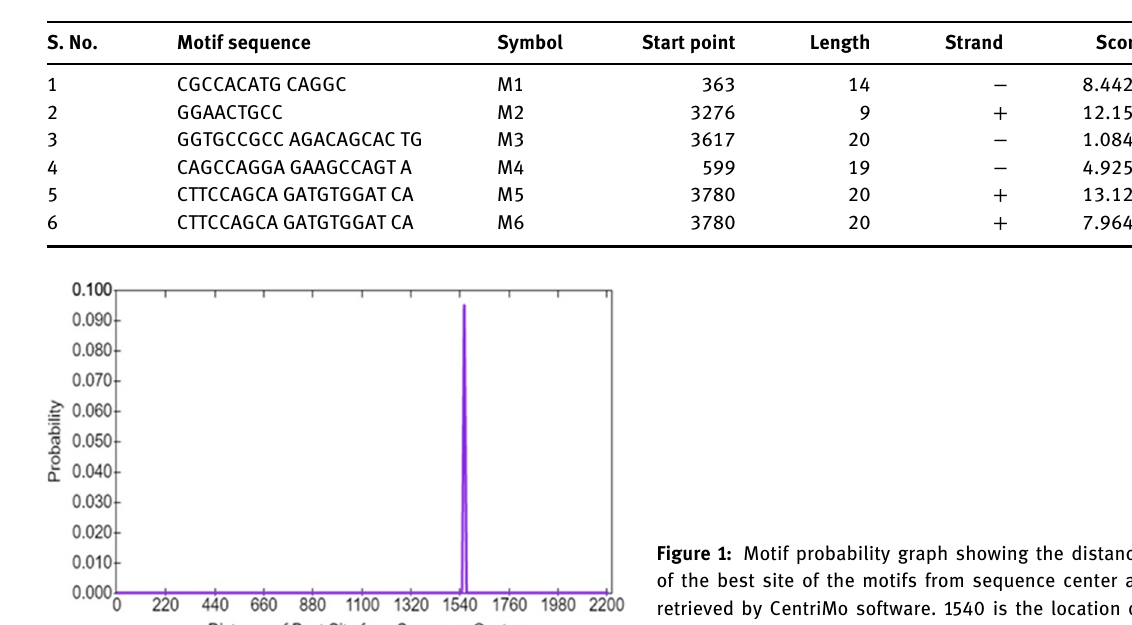
Figure 1: Motif probability graph showing the distance of the best site of the motifs from sequence center as retrieved by CentriMo software. 1540 is the location of